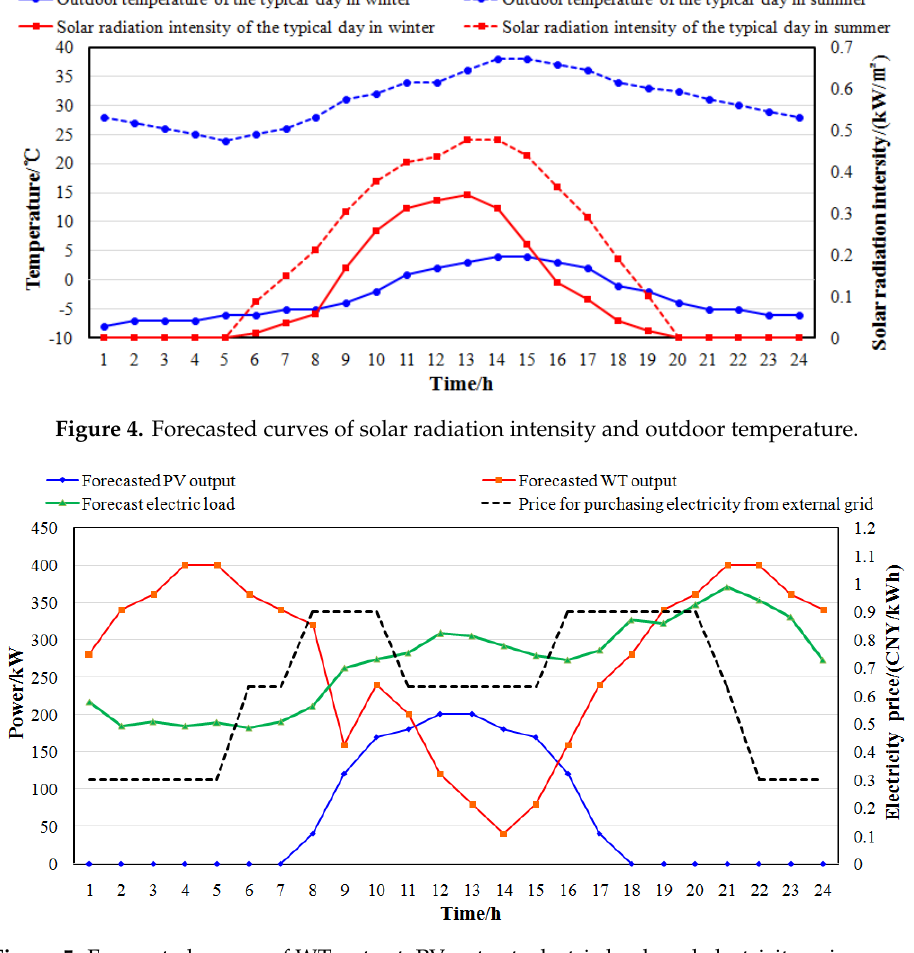
Table 6. Specification of MTs.